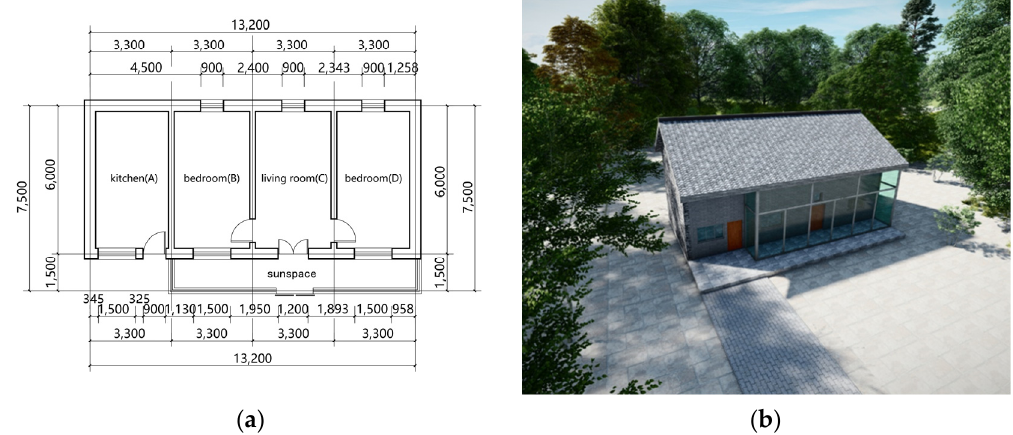
Figure 7. The improved model ( a ) plan of slate dwelling, ( b ) model of slate dwelling.